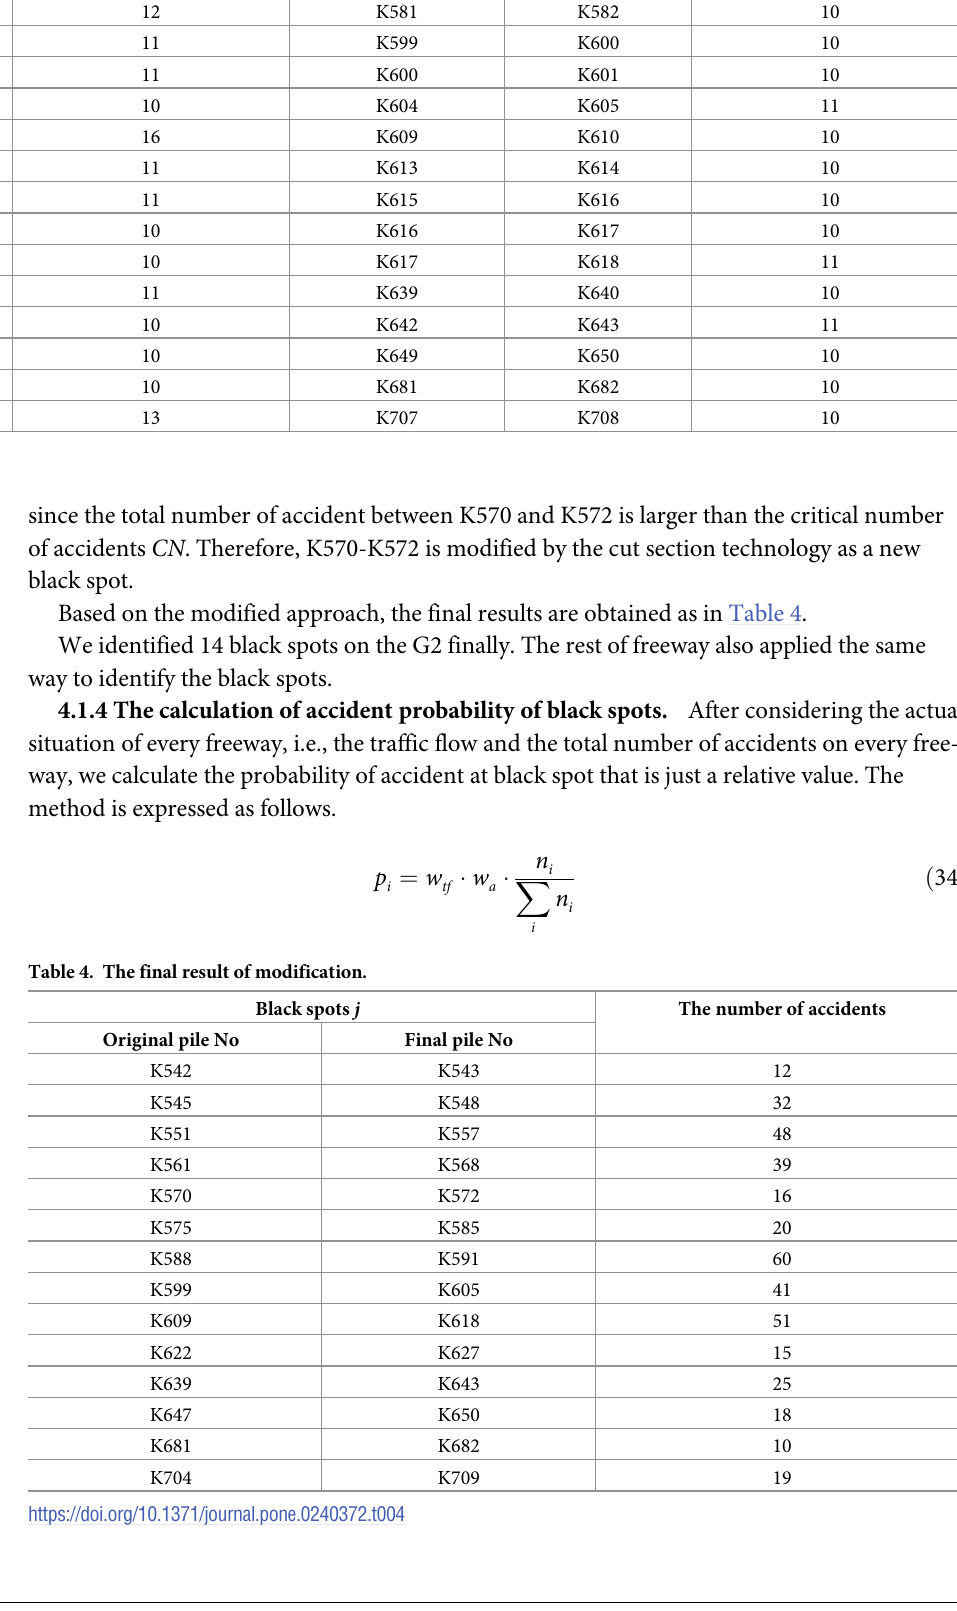
Table 3. The initial result of the identification of black spots.